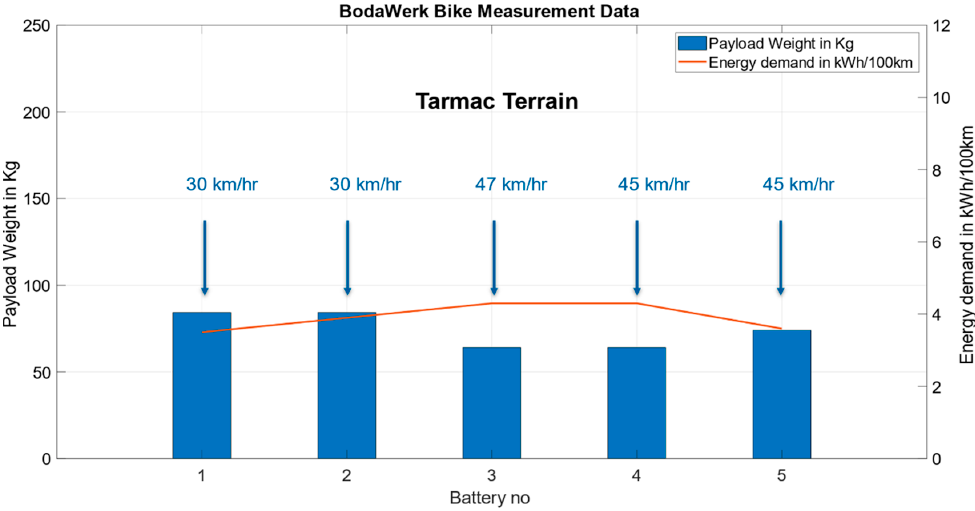
Figure 17. Distance-related battery electricity demand depending on the road surface (Bodawerk).